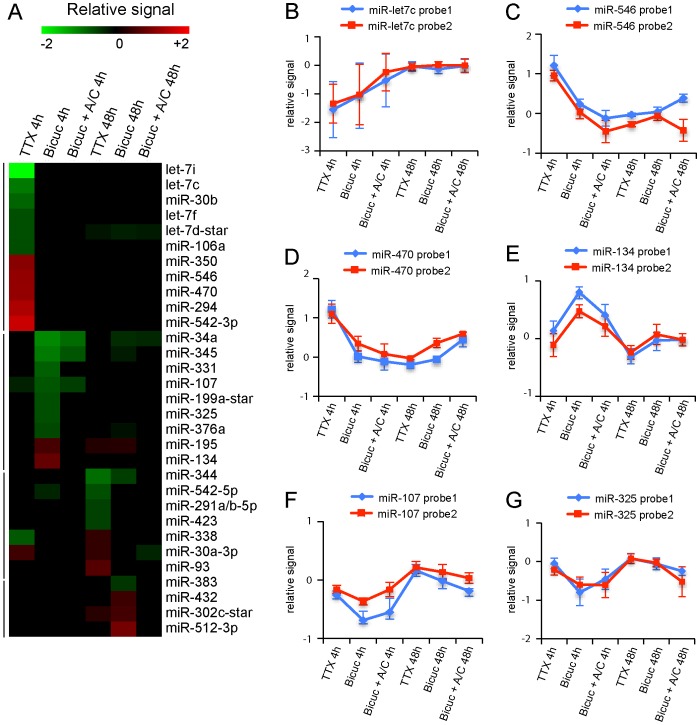
miRNA expression profiling following prolonged changes in global network activity.A) Heat map showing relative expression levels of miRNAs in mature hippocampal neurons (21 days) that are significantly changed following 4 hours and 48 hours 2 μM TTX and 4 hours and 48 hours 40 μM Bicuculine treatment compared to non-treated neurons in a green (negative fold-change) to red (positive fold-change) scale. To control for the specificity of the Bicuculine treatments, these experiments were also performed in the presence of APV and CNQX. Selection criteria were: absolute fold change value greater than or equal to 1.5 for 4 hour treatments and 1.4 for 48 hour treatments (P<0.05) and changes in Bicuculine expression are blocked by APV/CNQX. B–G) Graphs of relative signal (normalized fold changes) of miRNA expression following TTX and Bicuculine treatments compared to non-treated mature hippocampal neurons. The blue and red lines indicate the two probes used to detect the expression of indicated miRNAs, which were spotted in duplicate on the LNA array.